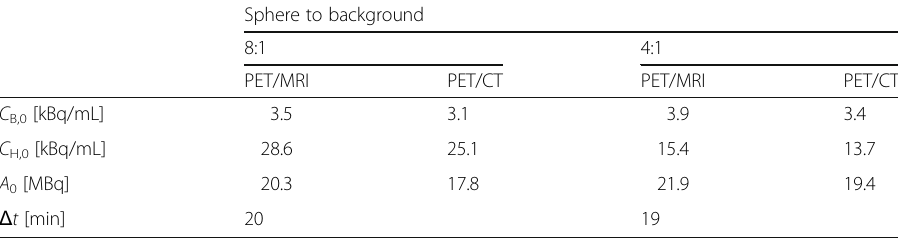
Table 1 Calculated activity concentrations in background ( C B,0 ) and in hot spheres ( C H,0 ), total activity ( A 0 ) at scan start, and time between scanning ( Δ t ) at the PET/MRI and the